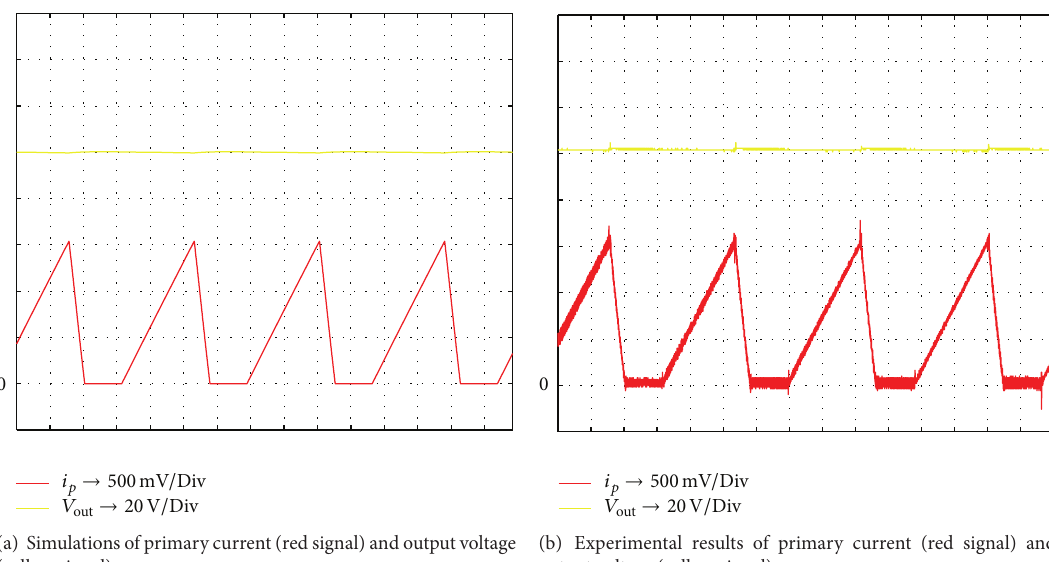
Figure 10: Period-1